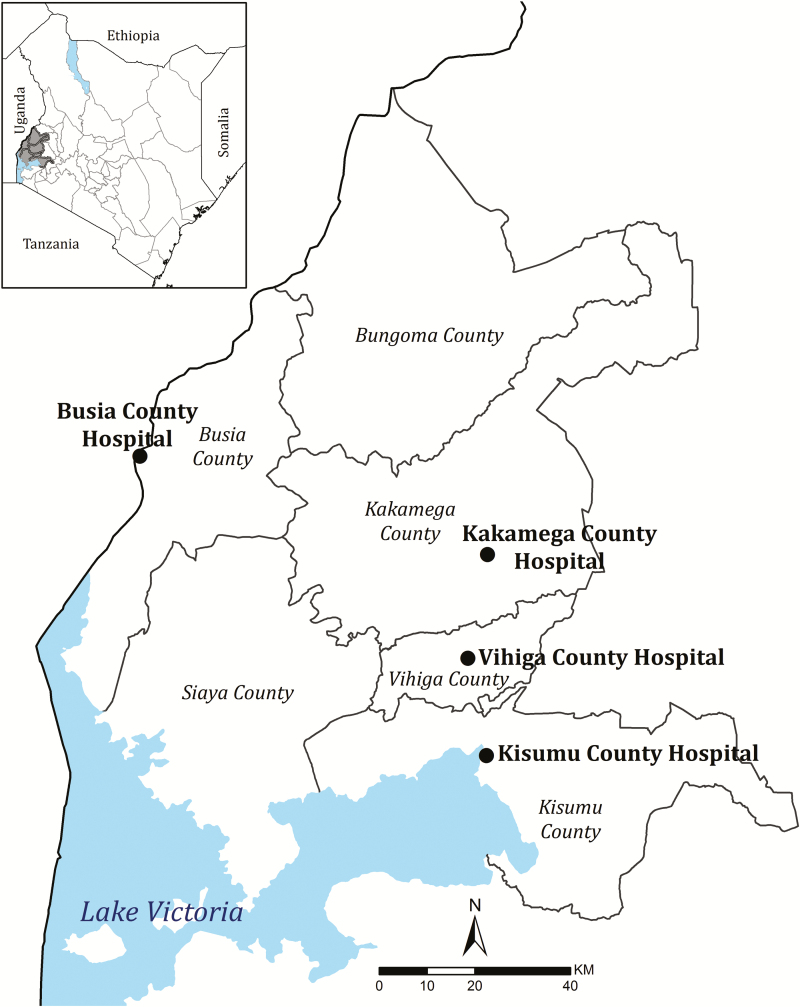
Map showing locations of study county hospitals in Western Kenya.